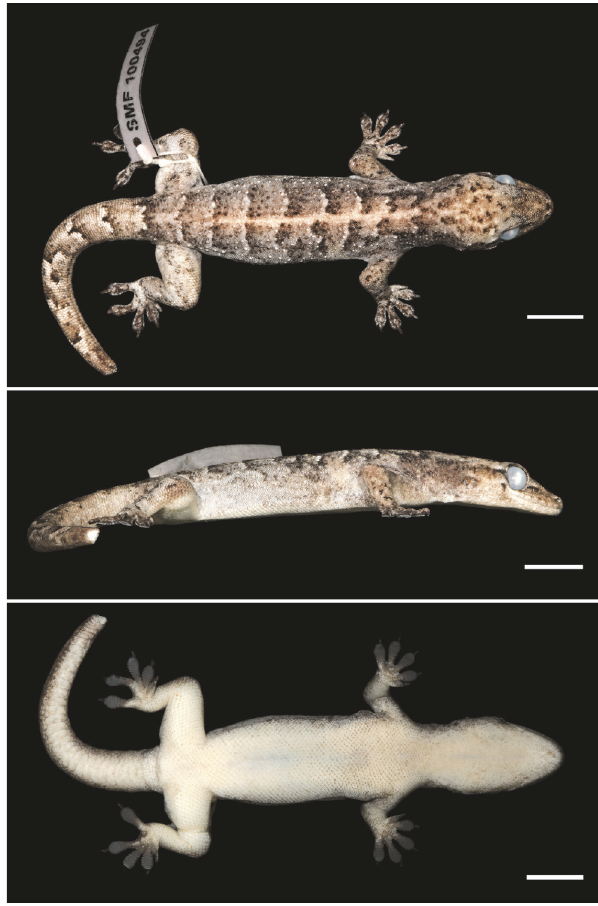
Figure5:Dorsal(above),lateral(middle),andventral(below)views of the holotype (SMF 100494) of Phyllopezus heuteri . Scale bars = 10